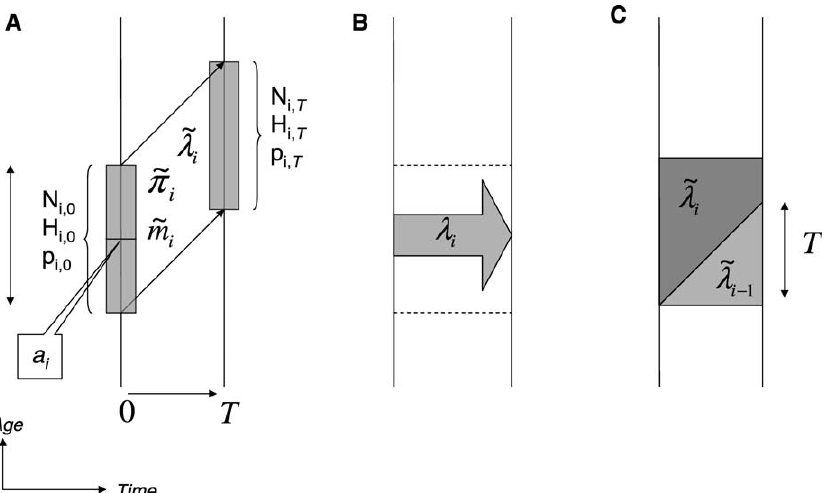
Figure 1. Lexis Diagrams Showing Values Used in the Methods Two serosurveys T years apart quantify prevalence in age groups of width r . One age group ( i ) is shown. (A) At time j , N i,j is the total number in survey; H i,j is the number infected; p i,j is HIV; ~ p i is the fraction of infected individuals that survive between surveys; ~ m i is mortality rate of infected individuals in the cohort; ~ k i is the rate of HIV incidence in the cohort. N and H are not used required to use the methods but do appear in the mathematical derivation. (B) Cross-sectional incidence ( ~ k i ). (C) Contributions to cross-sectional incidence estimate from incidence in two cohorts ( ~ k i and ~ k i (cid:2) 1 ). For details see main text and Text S1.